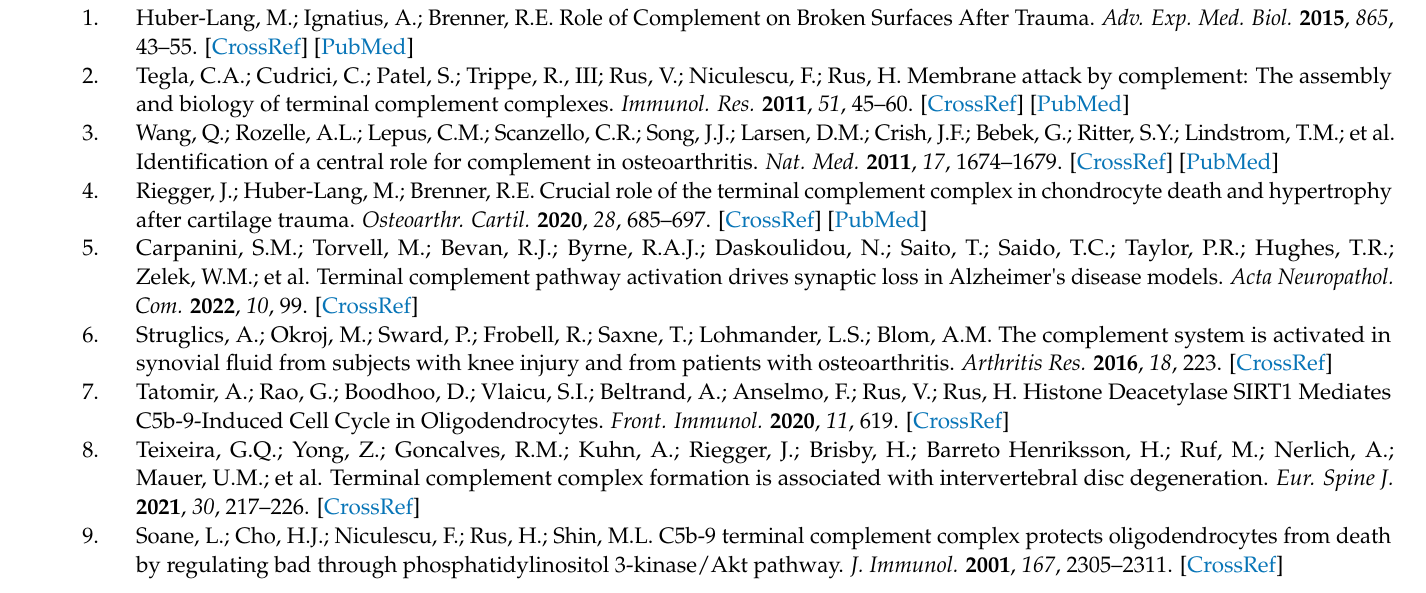
by µ CT; Figure S2: Zones considered in the TUNEL assay; Figure S3: Histopathologic assess- ment of lateral condyle sections; Figure S4: Histopathologic assessment of tibia plateau sections; Figure S5: TUNEL staining; Table S1: Primer for genetic characterization of the C6-deficiency; Table S2: OA scoring system; Table S3: Synovitis scoring